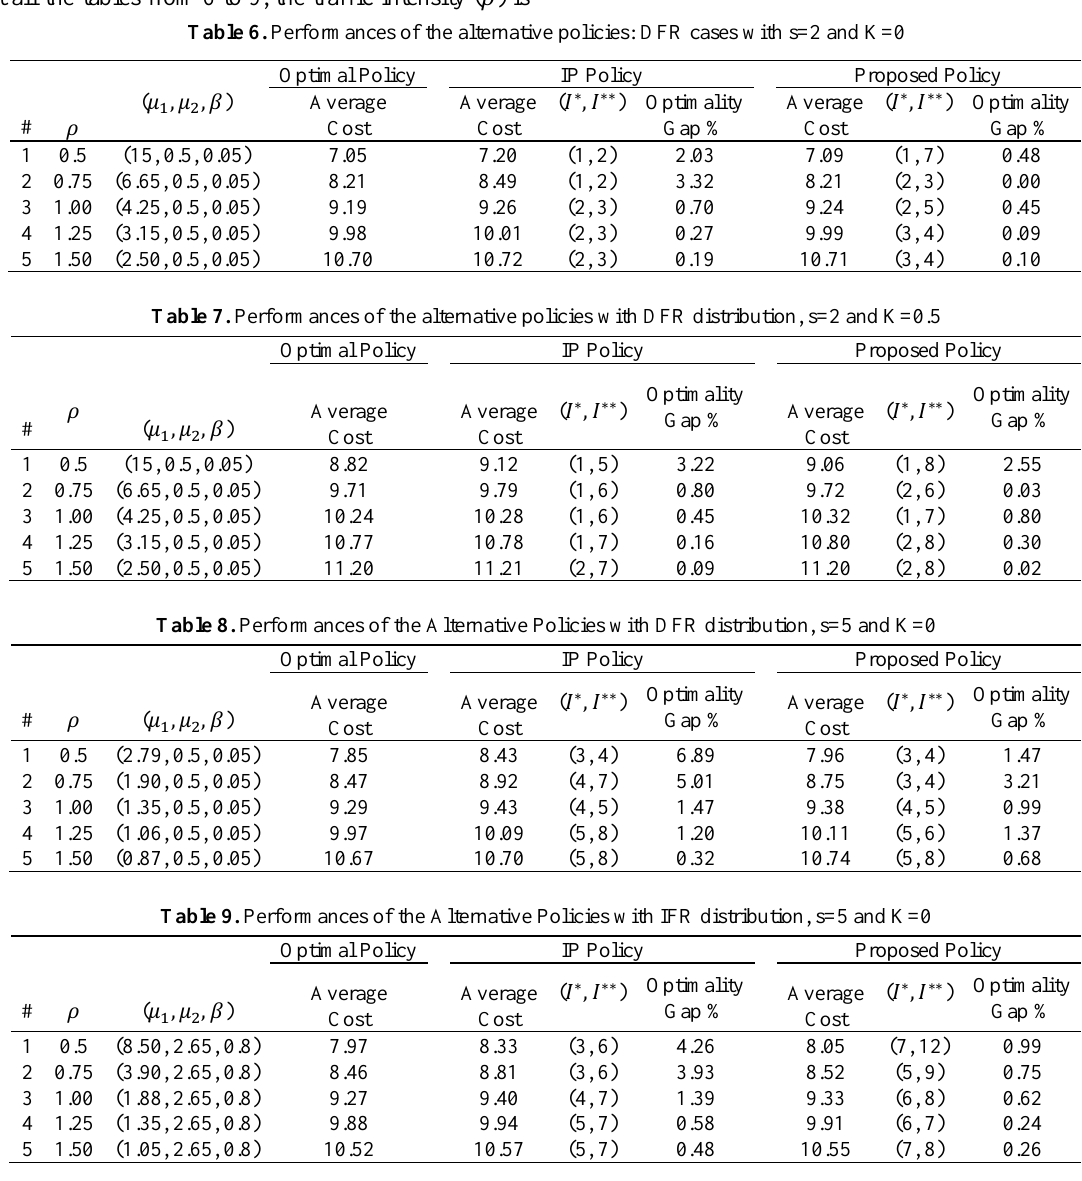
Table 10. Performances of the Alternative Policies with DFR distribution, s=5, K=0 and 𝜇 2 is changing Optimal Policy IP